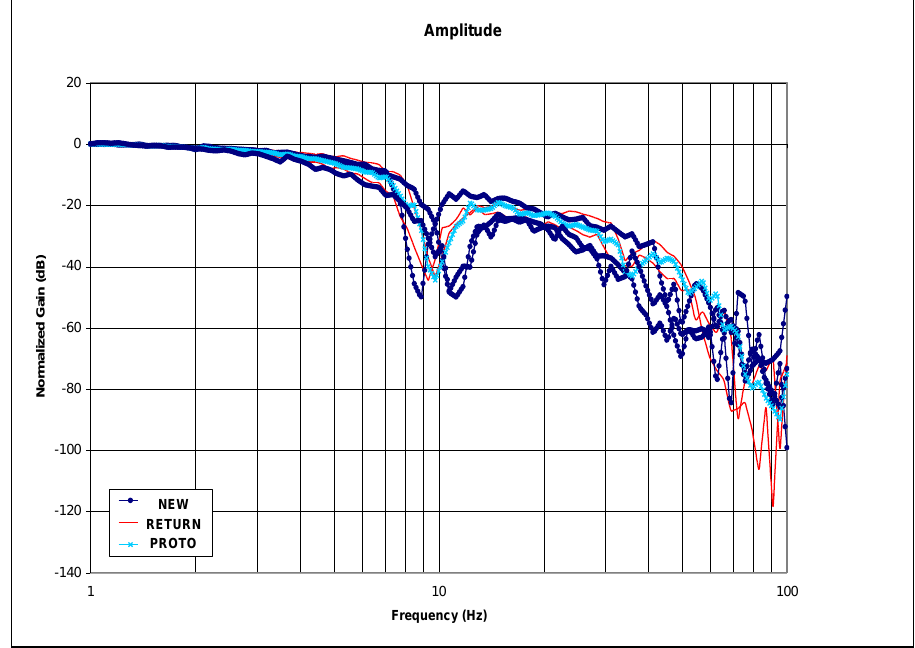
Figure 5. Normalized gains of the EFC valves with high amplitude.